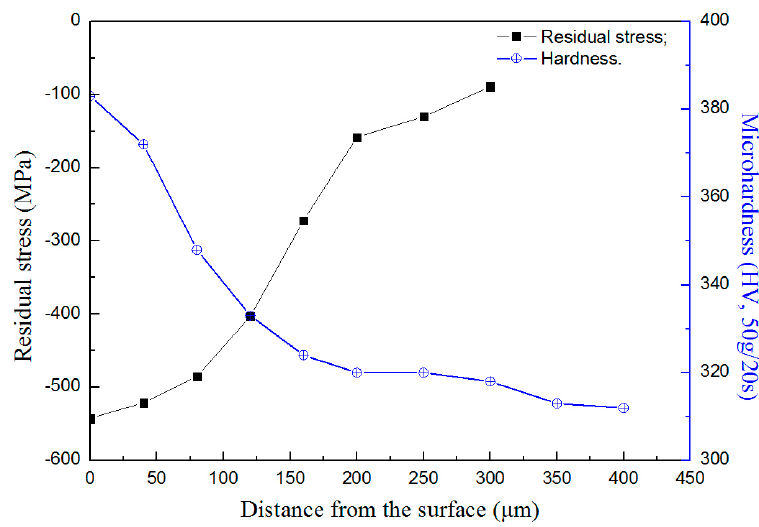
Figure 3. Distribution of compressive residual stress and micro Vickers hardness after UNSM.